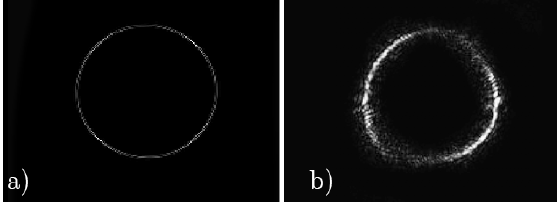
Figure 14. Far field diffraction pattern of helicoidal axicon. ( a ) Theoretical; ( b ) experimental.